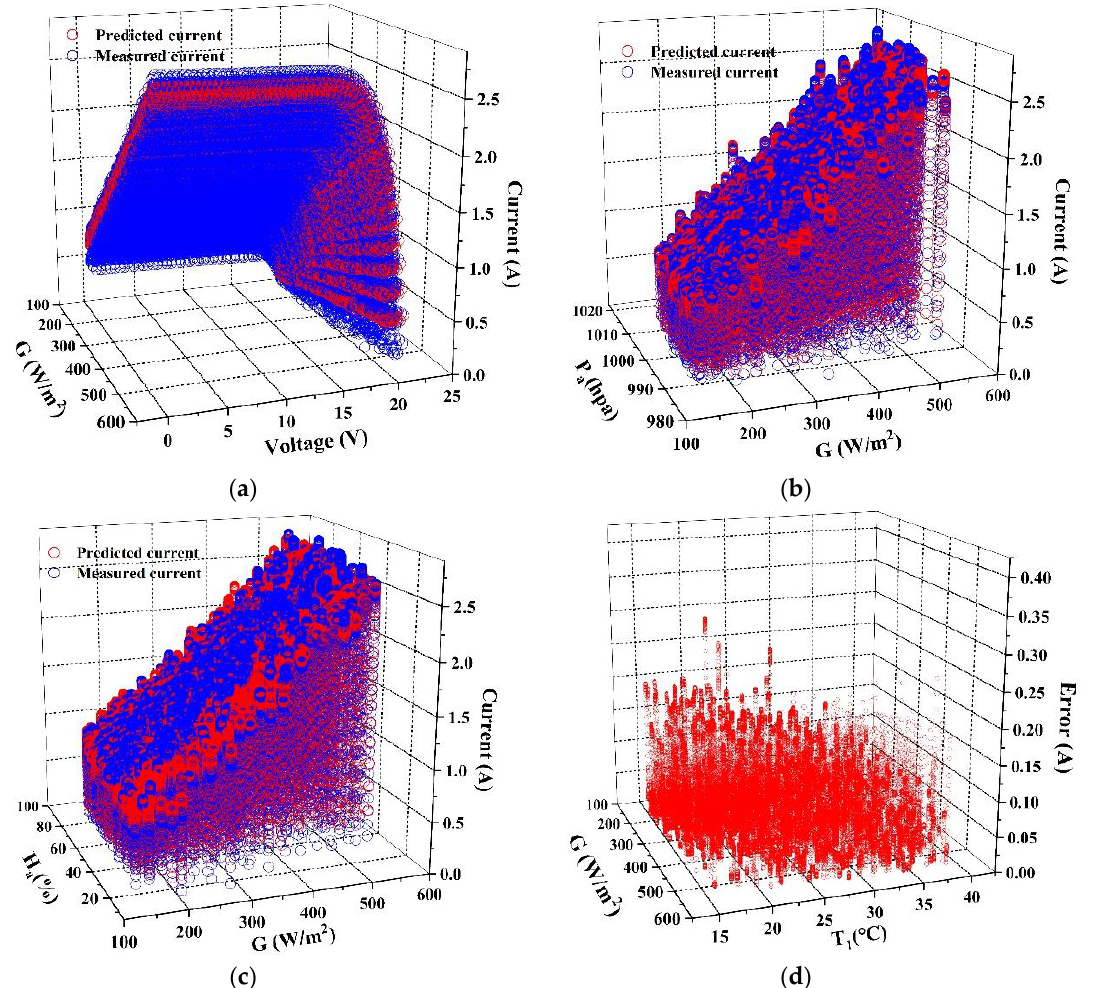
Figure 8. Analysis of the predicted value form CNN model. ( a ) Changes of the current with G and V ; ( b ) Changes of the current with G and P a ; ( c) Changes of the current with G and H a ; ( d ) Changes of the error with G and T 1 .